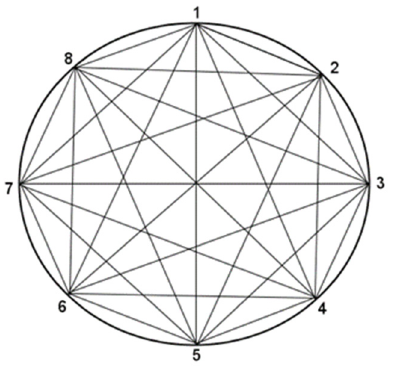
Figure 1. Example of an 8-point diffraction mesh.